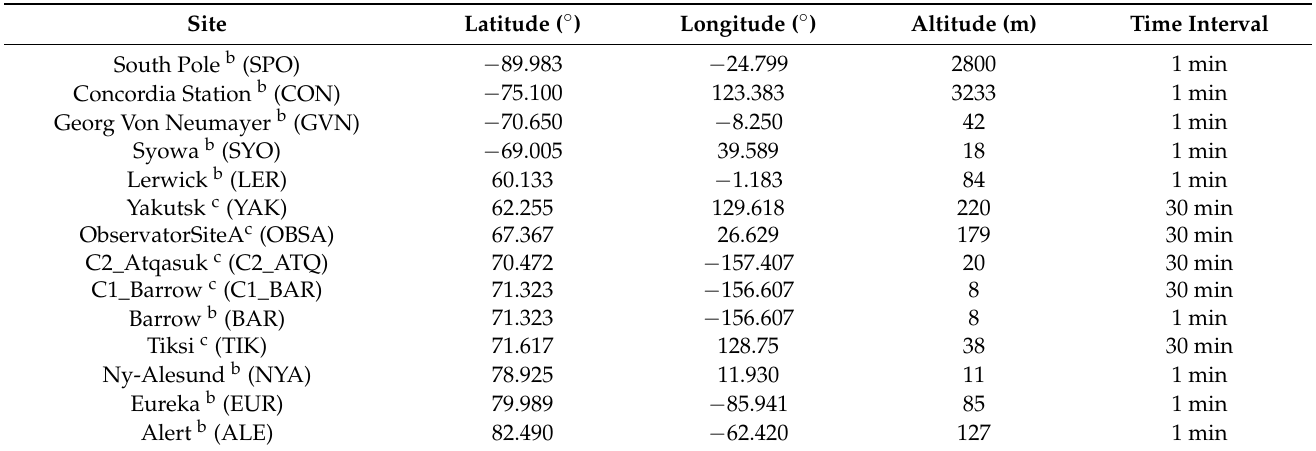
b Indicates that station belongs to BSRN and c indicates that site belongs to CEOP.